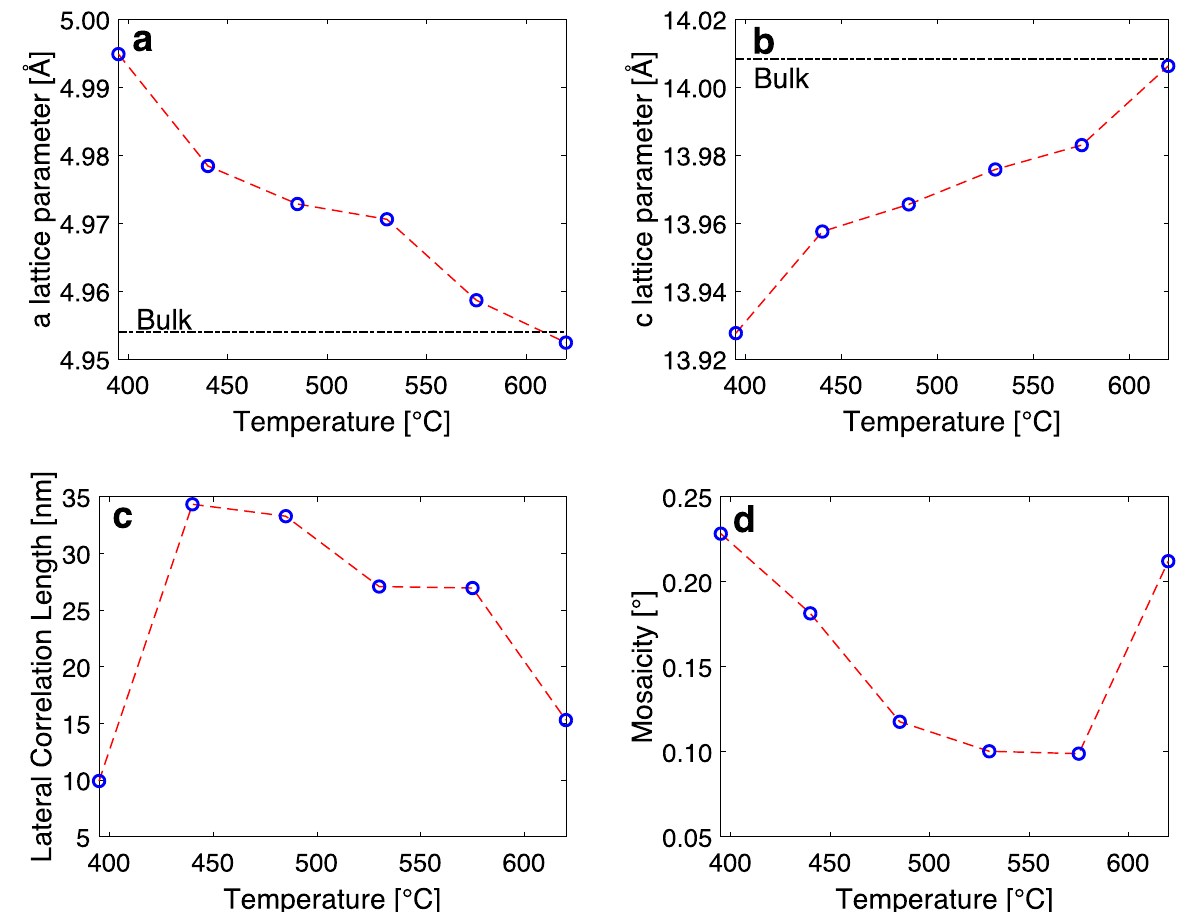
Figure 2. ( a , b ) The a and c lattice parameters and ( c , d ) the lateral correlation length and mosaicity extracted from the RSM of the (1 0 − 1 10) peak of V 2 O 3 as a function of growth temperature.